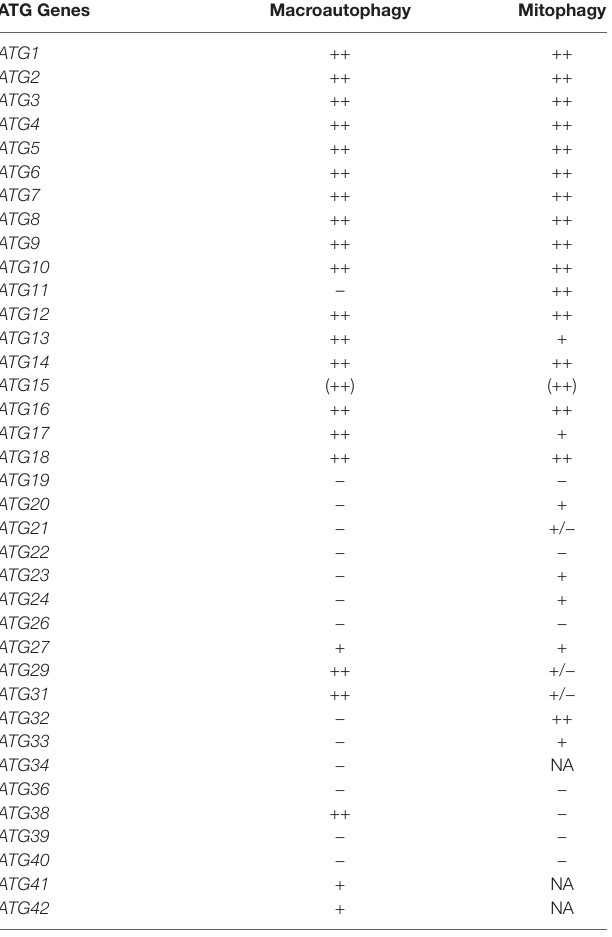
TABLe 1 | Requirement of ATG genes for macroautophagy and mitophagy in S. cerevisiae . ATG